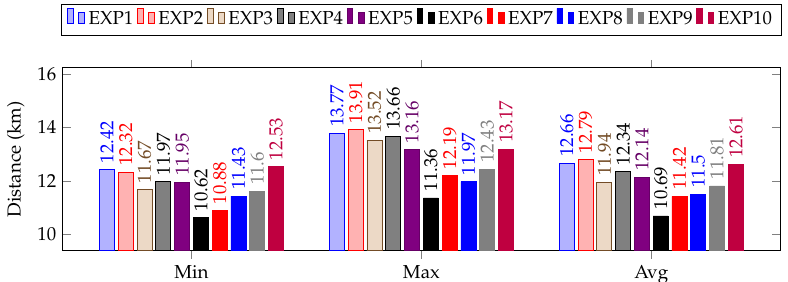
Figure 8. Distance (minimum, maximum, and on average) traveled by the swarm in all experimen- tal scenarios.